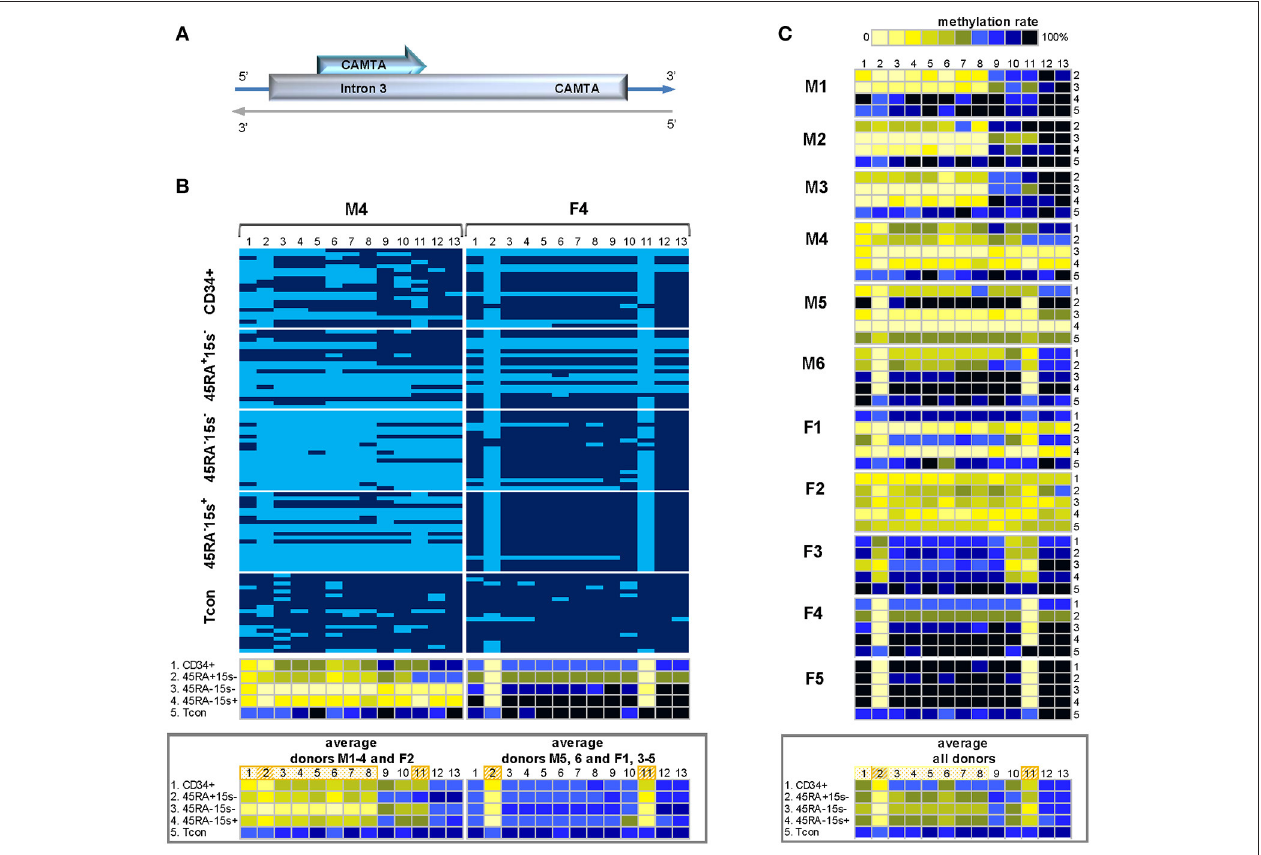
FIGURE 2 | Methylation pattern of CAMTA1 intronic region. CAMTA 1 intronic region is more demethylated in Treg subsets as compared to CD34 + cells and Tcon within the 200 bp region containing CpGs 1-8. CpGs 2 and 11 are strikingly more demethylated in both Treg and CD34 + cells. (A) Schematic presentation of CAMTA1 encoded on chromosome 1q3.6. (B) Two methylation patterns of CAMTA1 in five cell populations: CD34 + (1), CD45RA + CD15s − (2), CD45RA − CD15s − (3), CD45RA − CD15s + (4), and Tcon (5) of representative donors M4 (pattern 1) and F4 (pattern 2). Average methylation percentages for donors following the two patterns presented in panels below. CpGs 1-13 are numbered relative to the 5 ′ -3 ′ direction of the coding (top) strand. Each horizontal line represents DNA from one cell with unmodified C in light blue and m C in dark blue. Methylation percentage for each CpG site was calculated based on the number of m Cs in a total of 20 and summarized in panels below. (C) Methylation patterns of CAMTA1 intronic region of individual donors with the average methylation pattern for all donors presented in the panel below. See also Supplementary Figures 1 , 3